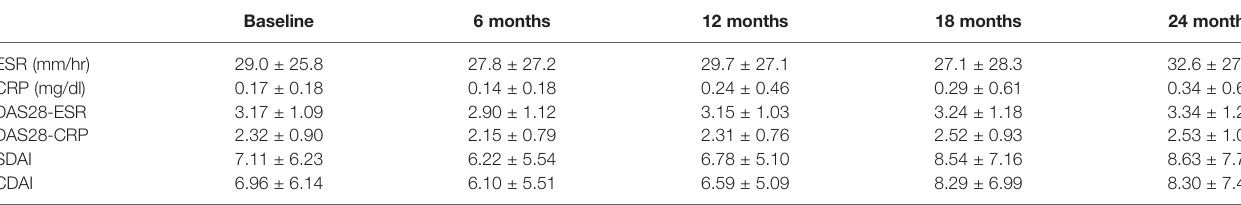
TABLE 2 | The changes of disease activity and in fl ammatory markers. Baseline